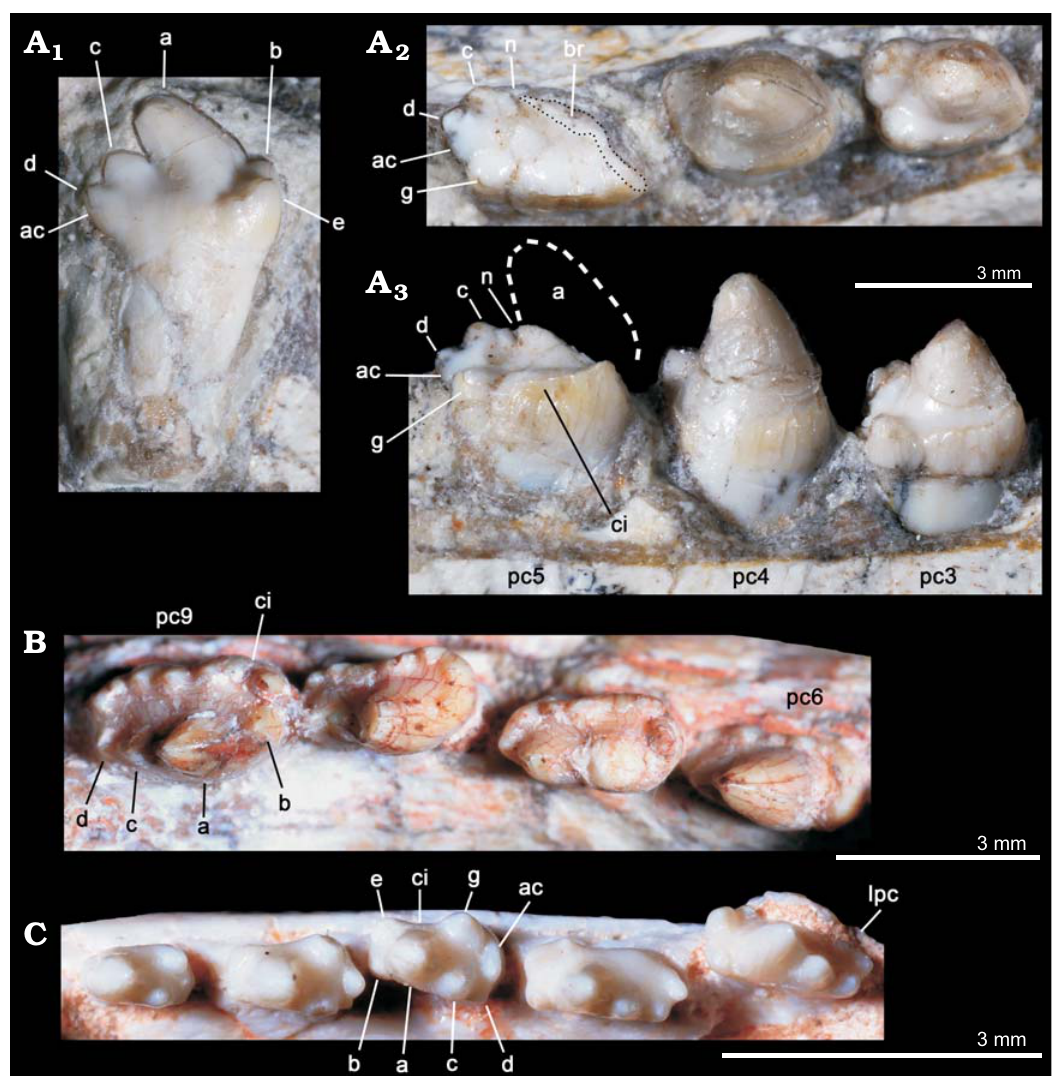
Fig. 5. Comparisons of postcanine teeth among selected eucynodonts. A . Candelariodon barberenai Oliveira, Schultz, Soares, and Rod rigues, 2011 (holo- type, MMACR PV-0001-T) from the Middle–Late Triassic of Rio Grande do Sul state, Brazil; detail of the lower postcanine dentition, including isolated tooth interpreted as a left posterior postcanine, in lingual view (A 1 ) and left pc3–5 in occlusal (A 2 ) and lingual (A 3 ) views. B . Prozostrodon brasiliensis (Barberena, Bonaparte, and Teixeira, 1987) (holotype, UFRGS-PV-248-T) from from the Late Triassic of Rio Grande do Sul state, Brazil; last right lower postcanines in occlusal view. C . Brasilitherium riograndensis Bonaparte, Martinelli, Schultz, and Rubert, 2003 (UFRGS-PV-0603-T) from from the Late Triassic of Rio Grande do Sul state, Brazil; left lower postcanines in occlusal view. The dashed line represents the shape of cusp a. Abbreviations: ac, accessory cusp; a–g, cusps of the crown; br, broken surface; ci, cingulum; lpc, last postcanine tooth; n, notch between a/c cusps; pc, lower